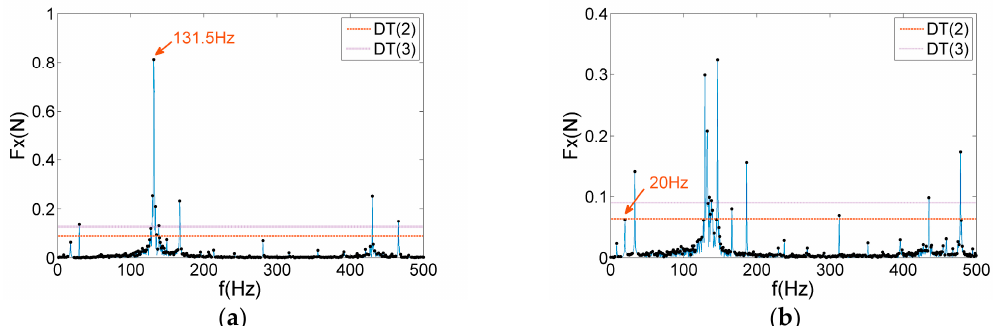
Figure 12. Peak threshold denoising of the micro-vibration signals: ( a ) 1800 rpm; ( b ) 2000 rpm.